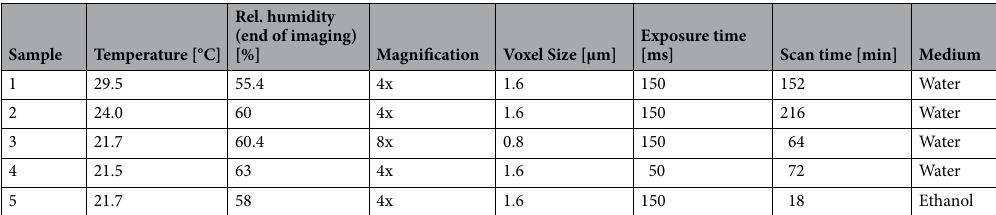
Table 1. Information of the imaging conditions for each sample.